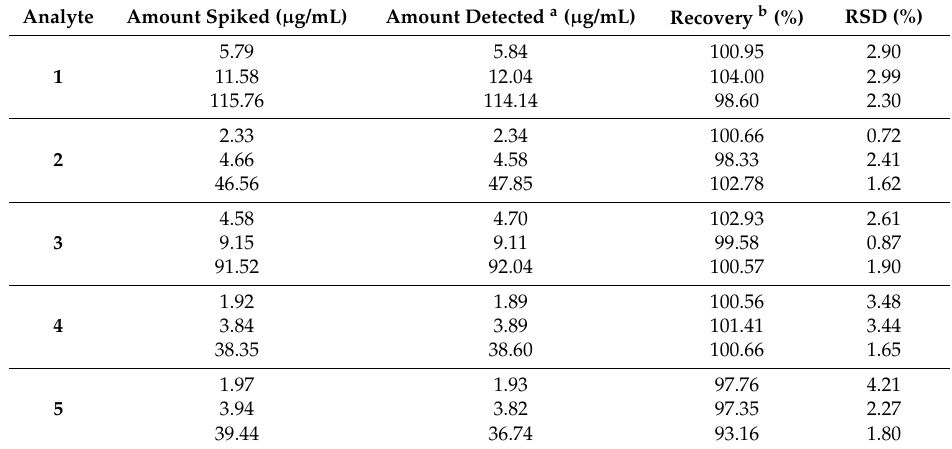
Table 3. Recovery of analytes in Pyrrosiae Folium ( n = 3). Analyte